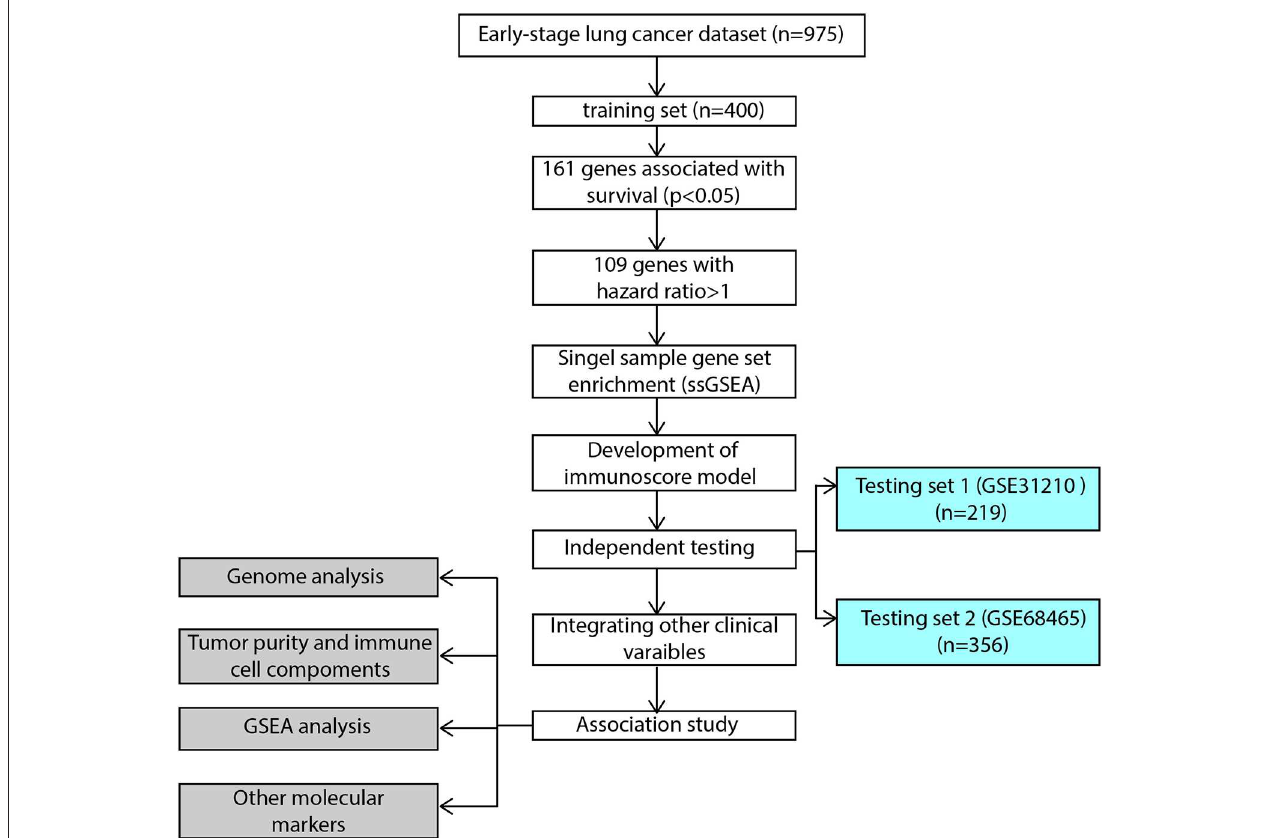
FIGURE 1 | Flowchart of the study. GSEA, gene set enrichment analysis.